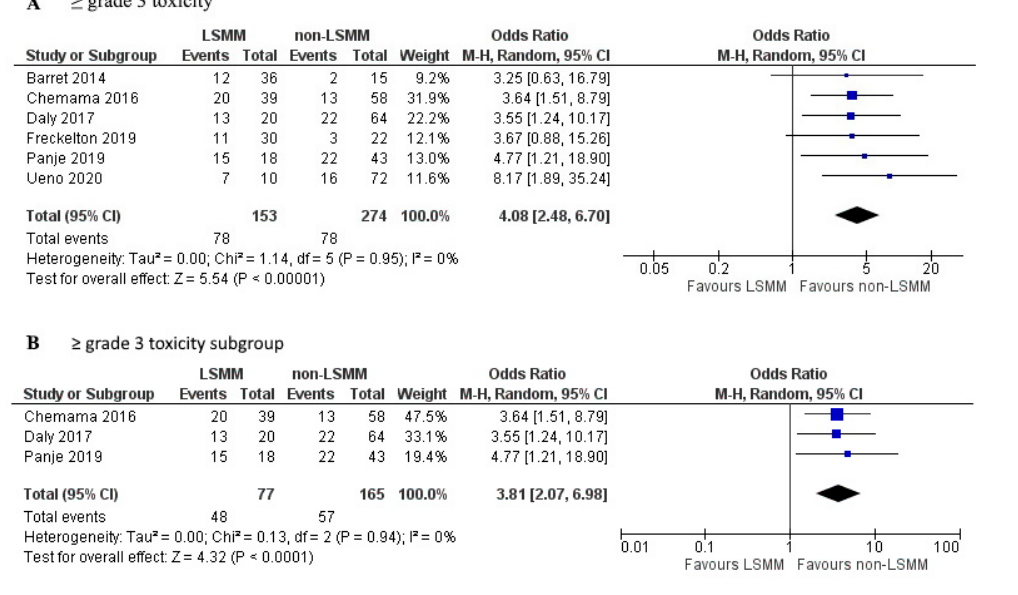
Figure 4. Forest plots for the association between low skeletal muscle mass (LSMM) and the odds to develop anti-cancer drug toxicity, specifically ( A ) toxicity ≥ grade 3 which was used as the toxicity endpoint in 6 studies. ( B ) shows a selection of studies that besides the same toxicity endpoint also used the same cut-off values established by Martin et al., 2013 [46], as well as the same measurement techniques using CT at the L3 vertebrae. For each forest plot, the combined effect of the studies is plotted with a black diamond.